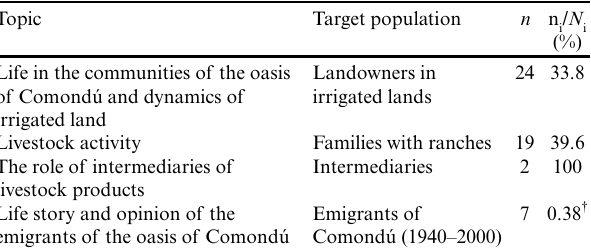
Table 1 . List of in-depth interviews classified by topic. The column ( n ) indicates the number of interviewees, ( N ) depicts the number of potential interviewees according to the target population, and ( n / N ) denotes the percentage of the ratio between interviewees i i and the potential interviewees for each topic.